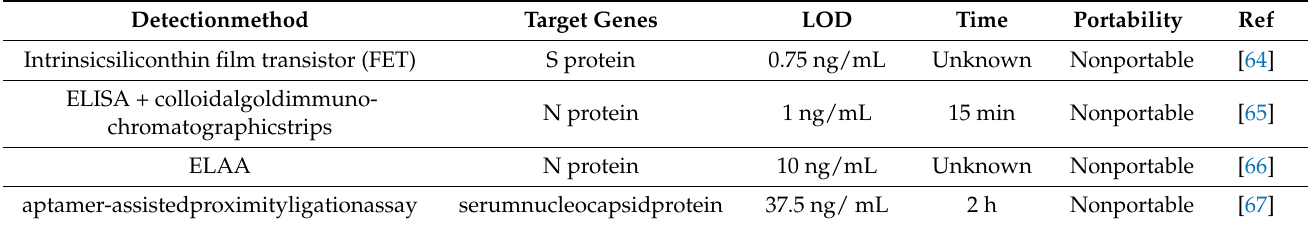
Table 4. Aptamer-based-biosensors for SARS-CoV-2